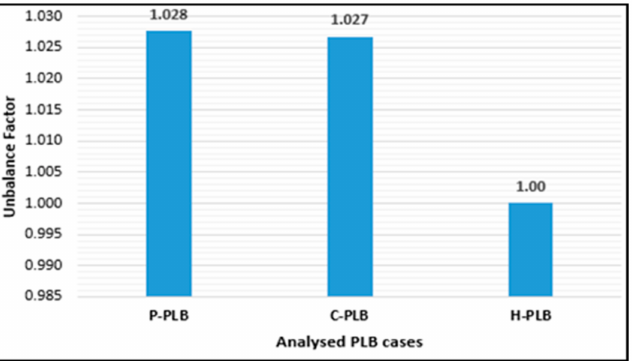
Figure 18. Comparison between the average values of UF calculated in the analysed PLB